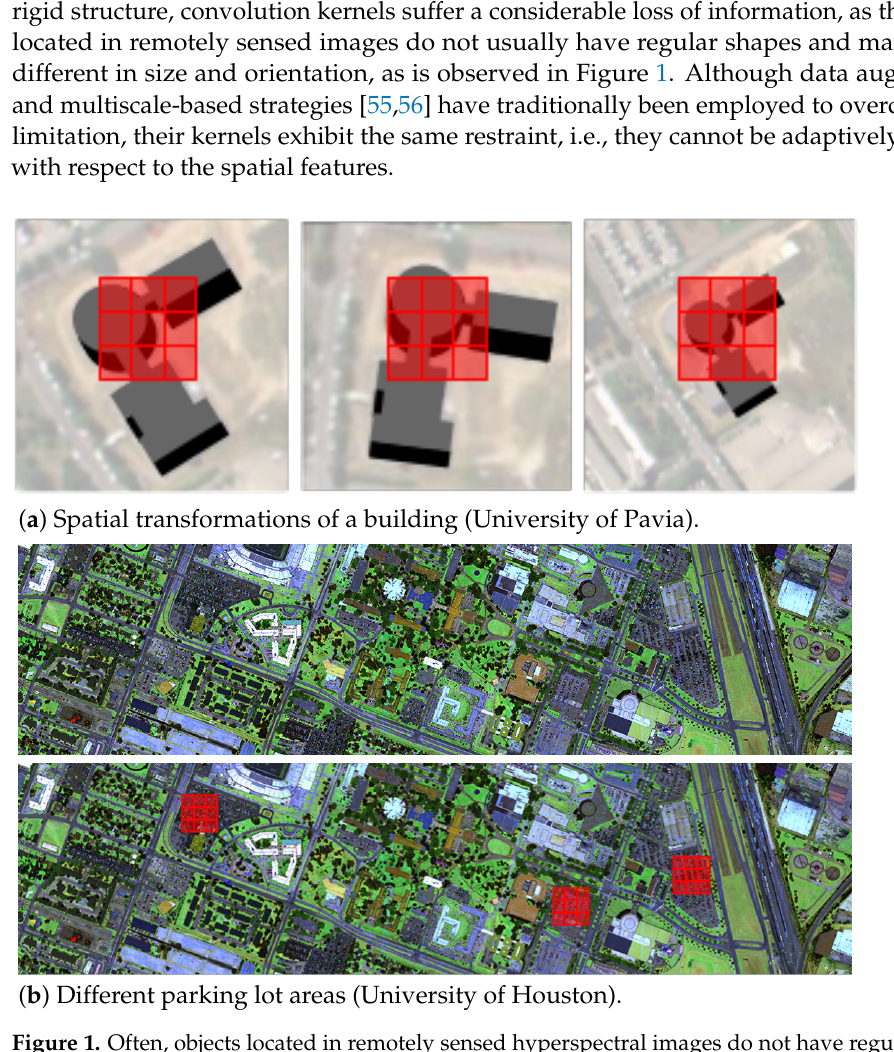
Figure 1. Often, objects located in remotely sensed hyperspectral images do not have regular shapes and may appear with different sizes and orientations. For instance, some data augmentation methods apply spatial transformations to the input samples to increase the size of the datasets and cover the variability in the data ( a ), whilst other scenes contain the same elements with different orientations and poses; for example, in ( b ) we can observe several parking areas, with different sizes and where the cars are placed differently. However, the convolution kernel disregards these spatial variations, defining a rigid regular